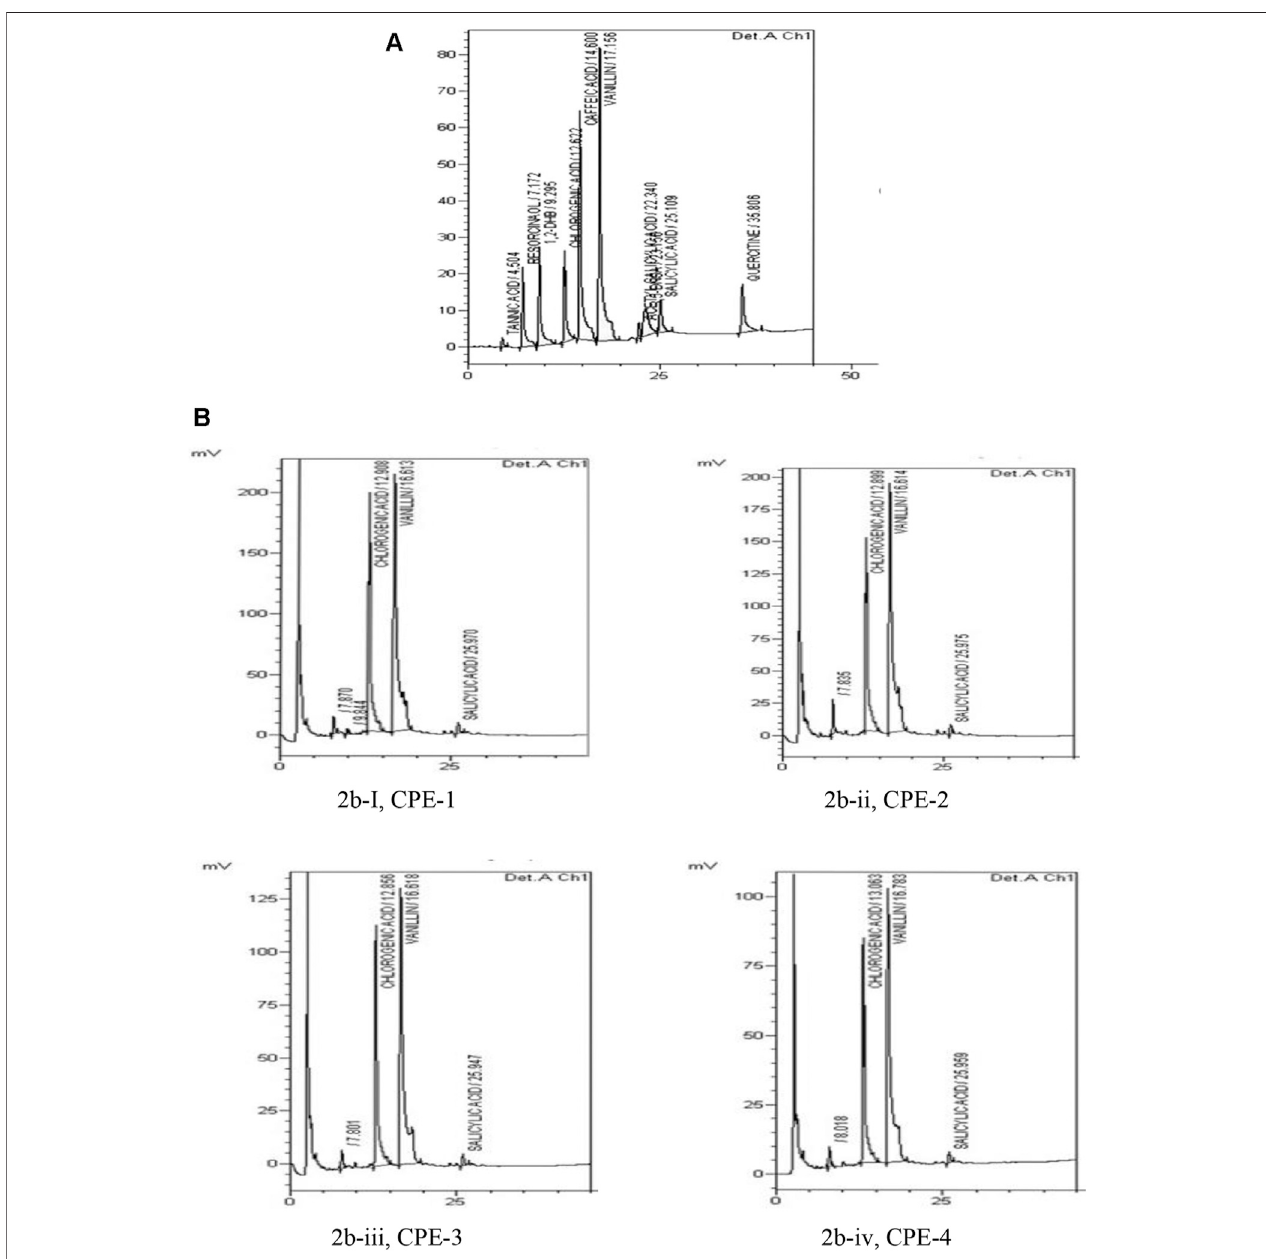
FIGURE 2 | Chromatogram of standard phenolic compounds (A) and chromatogram of samples (B) , such as CPE-1 (cid:1) 0.5 g (Bi) , CPE-2 (cid:1) 0.75 g (Bii) , CPE-3 (cid:1) 1 g (Biii) , and CPE-4 (cid:1) 1.25 g (Biv) .